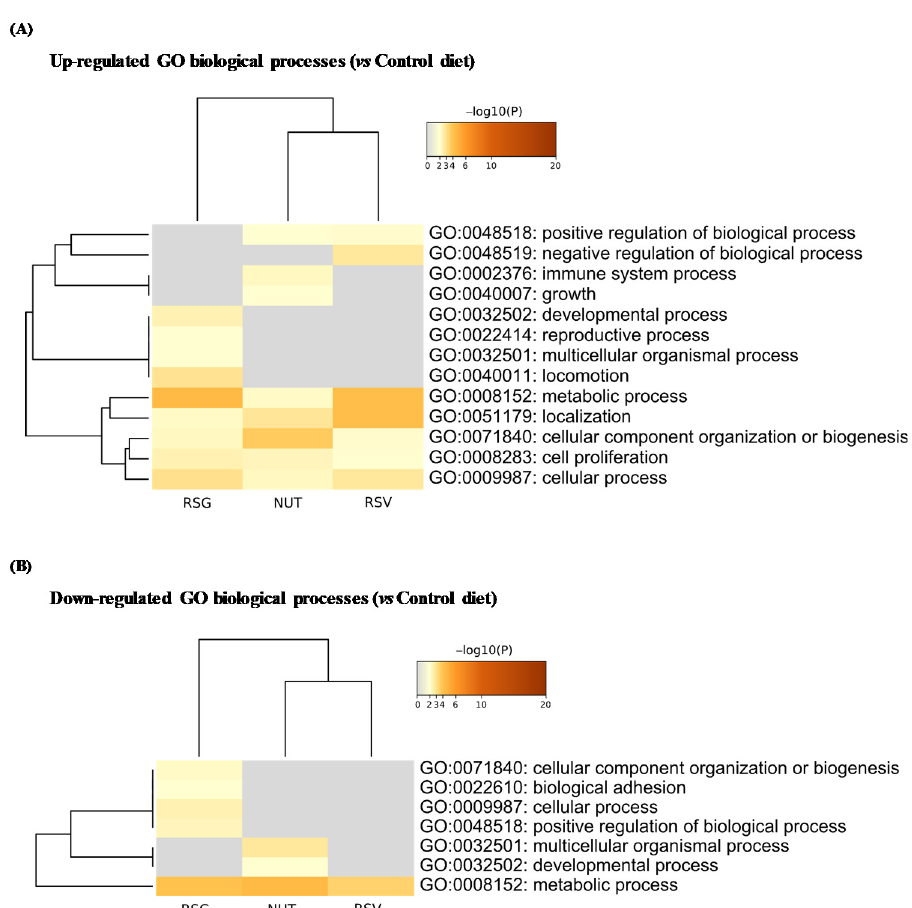
Figure 4. Enrichment analysis of Gene Ontology (GO) biological processes in differentially up- and down-regulated proteins from lasered mice retina. Based on ANOVA results, t -tests with Welch correction were further applied to identify significantly up- and down-regulated proteins in RSG, NUT, and RSV as compared with the control diet group (Co). Metascape database was then used to identify Gene Ontology (GO) enriched biological processes in up- ( A ) and down-regulated DEPs ( B ). Heatmaps show the top enrichment biological processes in up-regulated ( A ) and down-regulated DEP ( B ) term clusters, colored by − log 10 ( p -value). Threshold: 0.3 kappa score; similarity score > 0.3. The darker the orange is, the more significant the term. Gray color indicates a lack of signifi- cance.